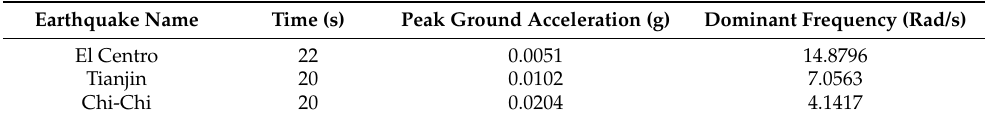
Table 1. Information of earthquake